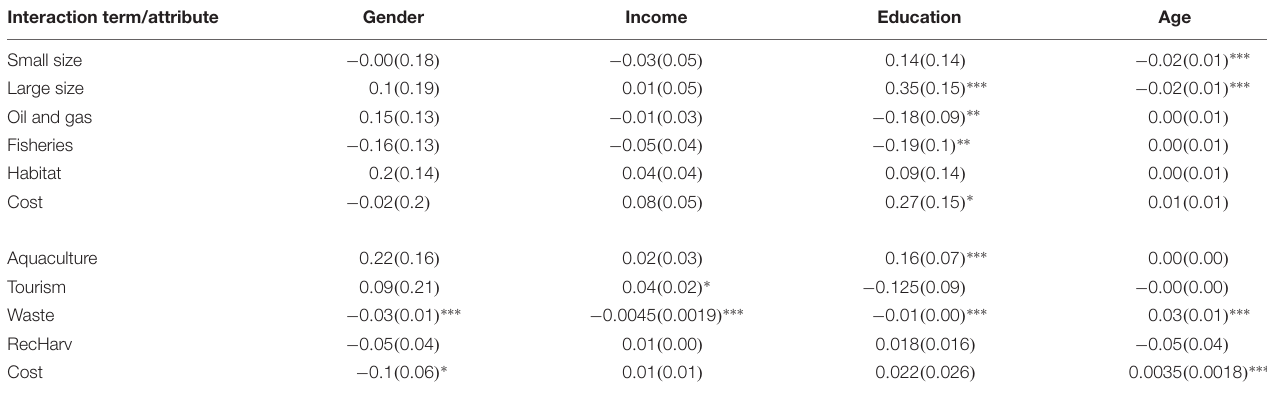
TABLE 5 | Socio-demographic interaction effects; average estimates for interaction parameters (standard error in